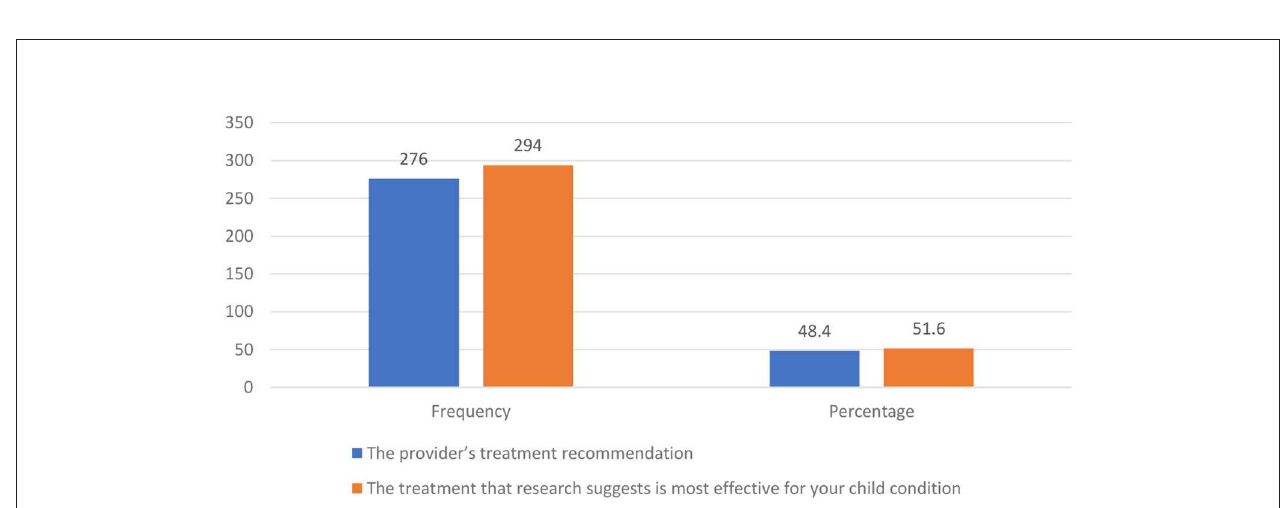
FIGURE 3 | Main influence on treatment decision of